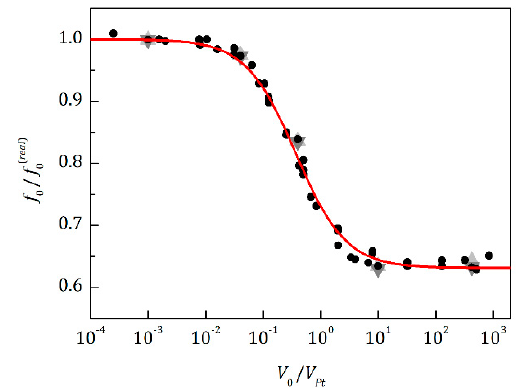
Figure 6. Relation between the transition frequencies, f 0 and f 0( real ) , obtained by pore simulations with ( f 0 ) and without ( f 0( real ) ) the sensor chamber, in dependence of different pore/tube volumes, V Pt , and different chamber volumes, V 0 . Simulations also contain different pressure amplitudes produced by the excitation membrane (1 Pa, 100 Pa, and 10,000 Pa, depicted as light gray up triangles, black dots, and dark gray down triangles, respectively). Red line shows a fit using y = (1 + abx )/(1 + bx ) , where a and b are the fitted coefficients and y and x are the ordinate and abscissa, respectively.